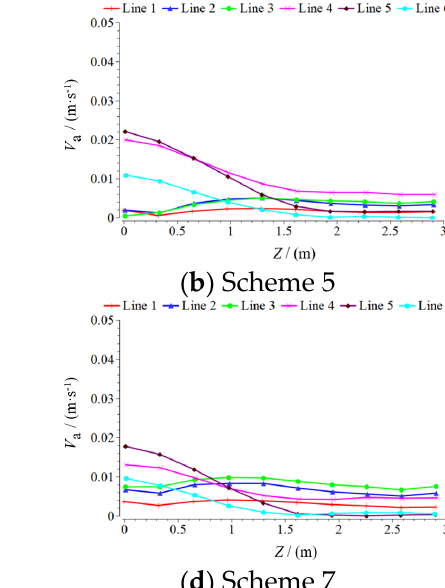
( d ) Scheme 7 Figure18. Diagram of axial velocity before the bell mouth in the sump 2# ( a ) Original scheme